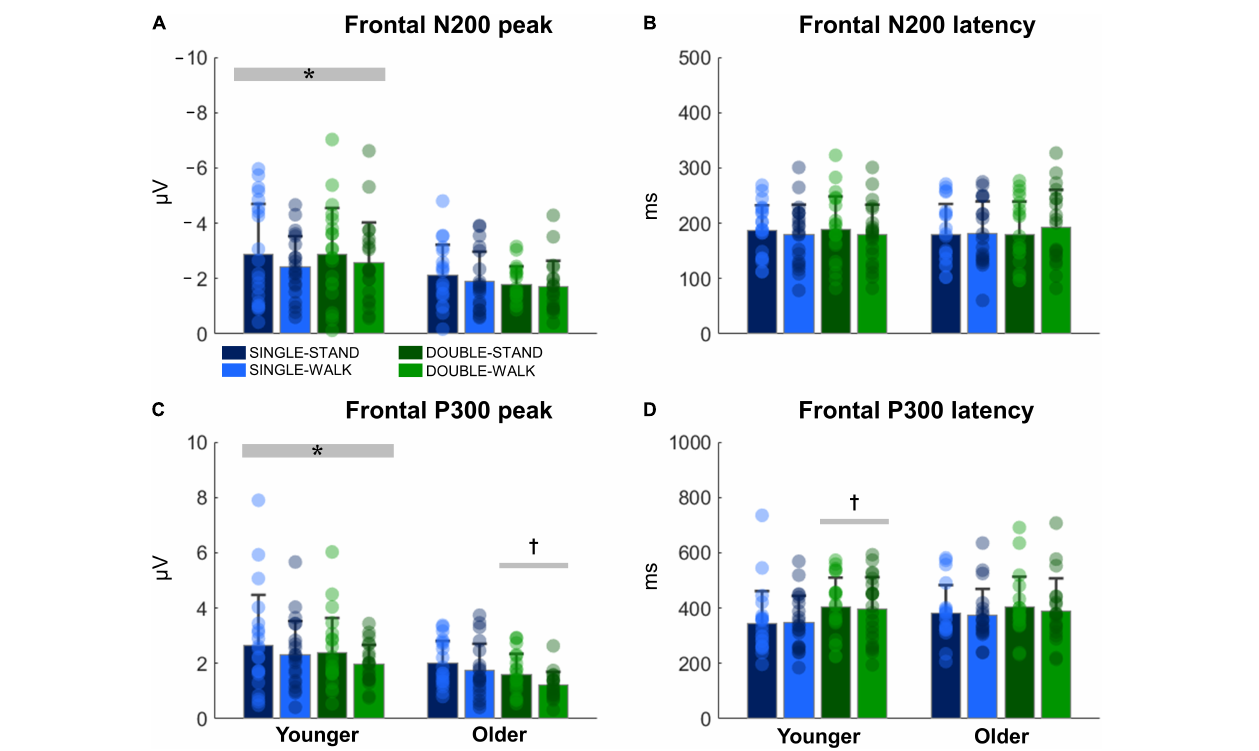
FIGURE 4 | Mean (SD) and individual values of N200 peak (A) , N200 latency (B) , P300 peak (C) , and P300 latency (D) in four conditions for the channel Fz: single stimulus while standing (SINGLE-STAND), single stimulus while walking (SINGLE-WALK), double stimuli while standing (DOUBLE-STAND), double stimuli while walking (DOUBLE-WALK) for younger and older adults. *Denotes significant difference in relation to older adults ( p < 0.0005). † Denotes significant difference in relation to single stimuli conditions for the same group ( p <